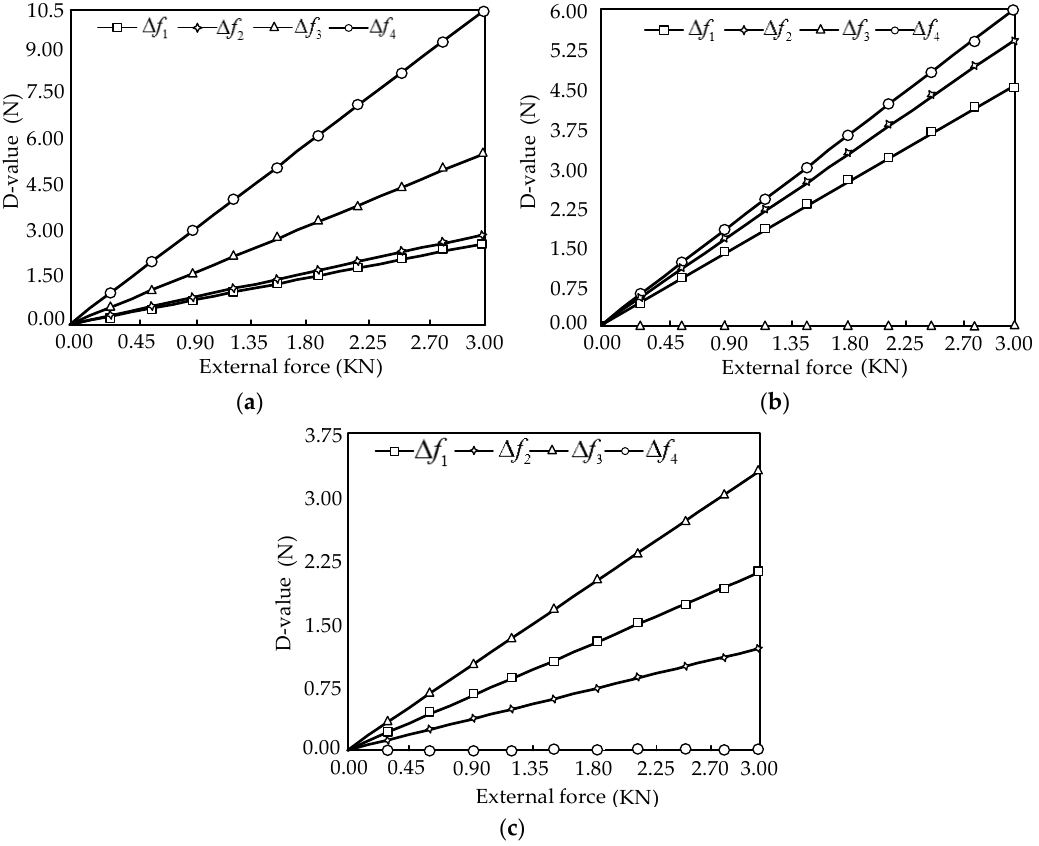
Figure 14. Relations of the force error and external force. ( a ) The relationships between the measurement force error ∆ f i ( i = 1, 2, 3, 4) and the external force component F X ; ( b ) The relationships between the measurement force error ∆ f i ( i = 1, 2, 3, 4) and the external force component F Y ( c ) The relationships between the measurement force error ∆ f i ( i = 1, 2, 3, 4) and the external force component F Z